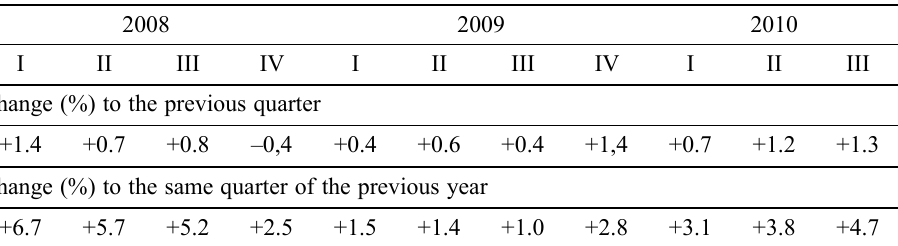
Table 1. Real GDP Growth per quarter (% growth 2000 =